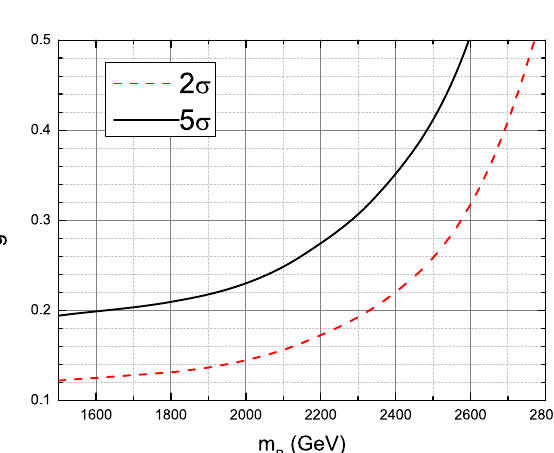
Fig. 7 Same as Fig. 6 but for the (cid:6) 2 bjj + / E T final state